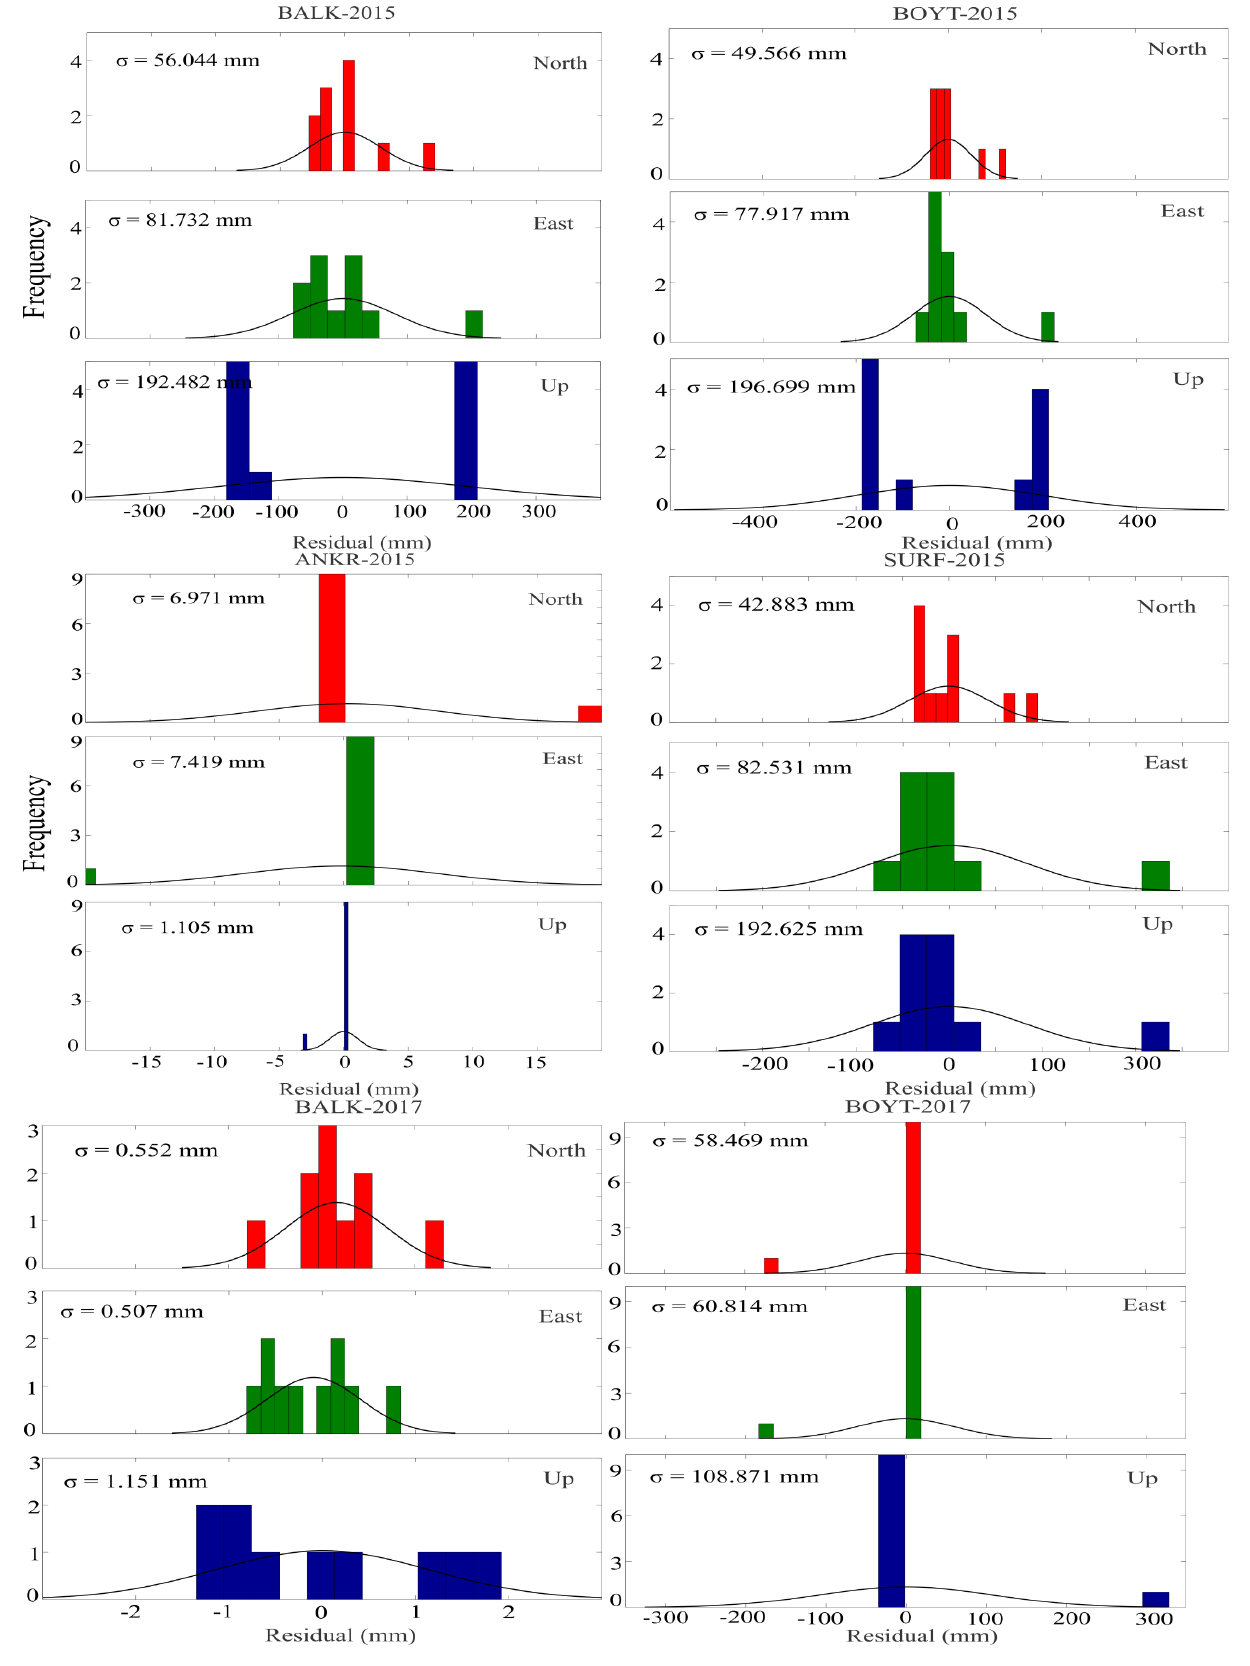
Figure 3: The coordinate reliability of GNSS sites from the year 2009 to